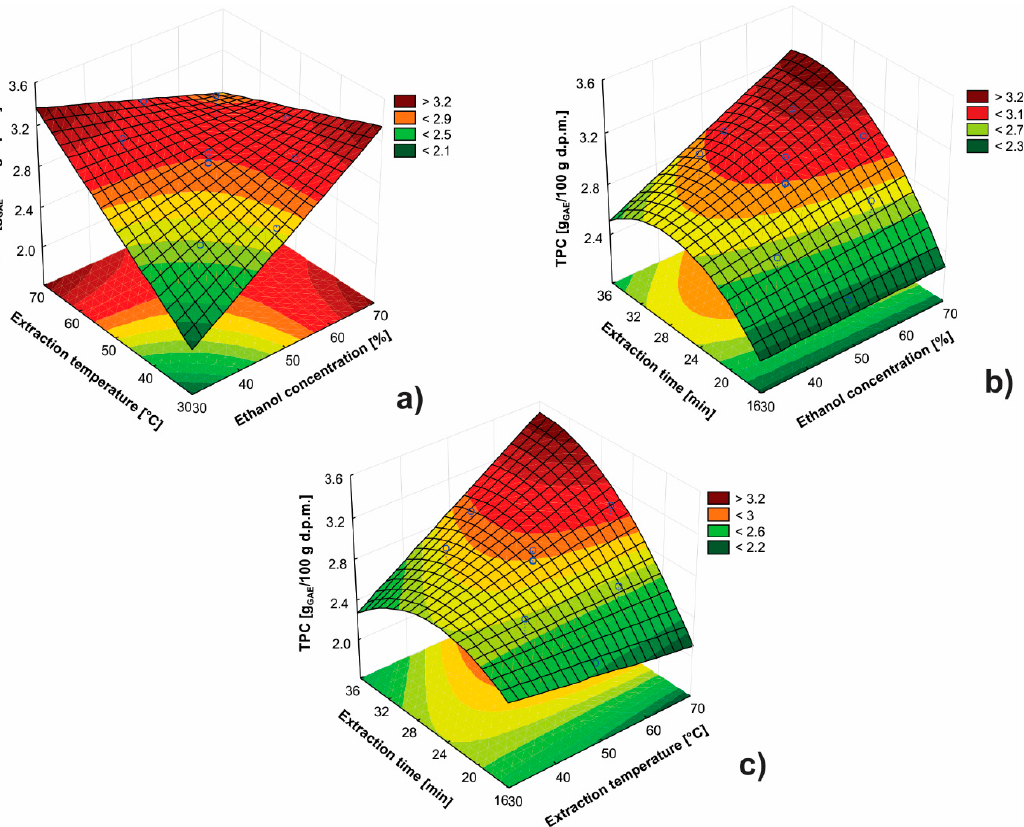
Figure 3. The impacts of: ( a ) ethanol concentration and extraction temperature for 25 min; ( b ) ethanol concentration and extraction time at 50 °C; and ( c ) extraction temperature and extraction time using 50% (v/v) ethanol on the TPC.